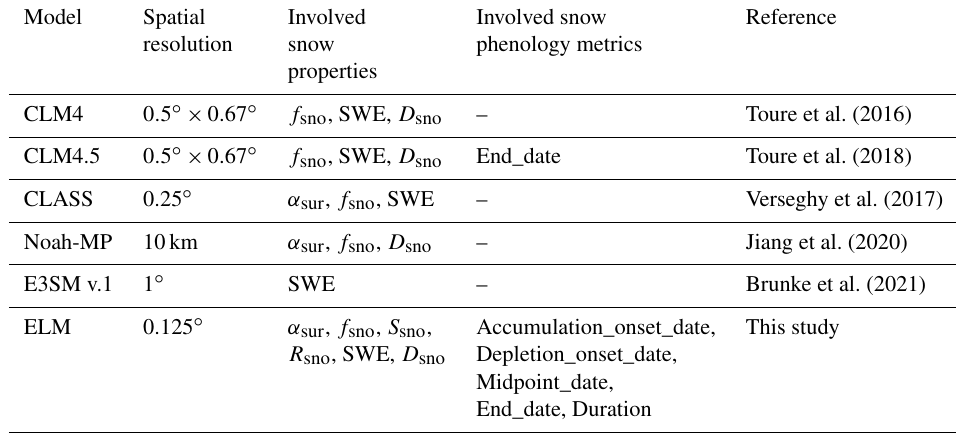
Table A2. Overview of some typical studies and this study on the evaluation of snow processes in land surface models (LSMs). Model Spatial Involved Involved snow Reference resolution snow phenology